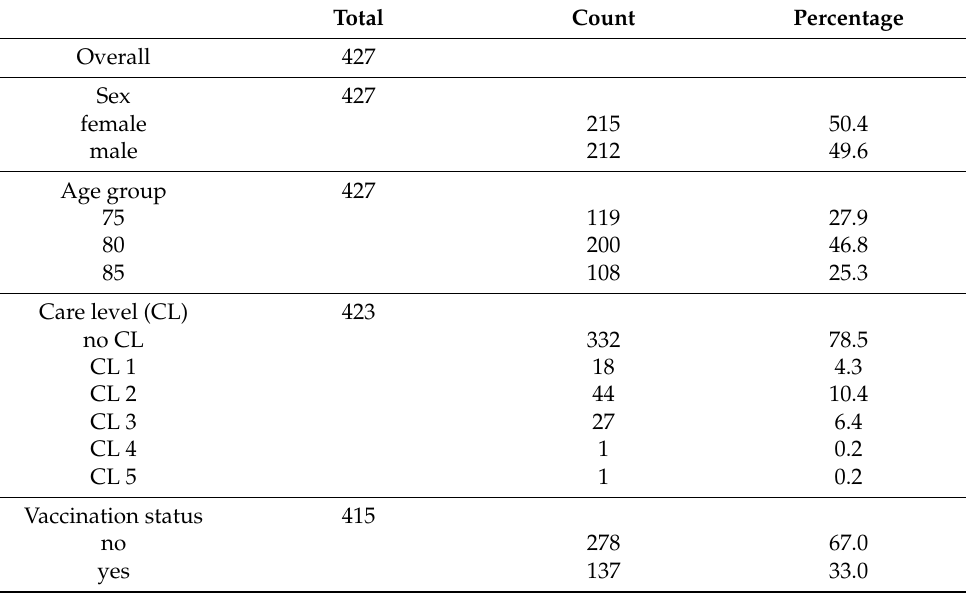
Table 1. Demographic characteristics of the participants; missing data due to incomplete